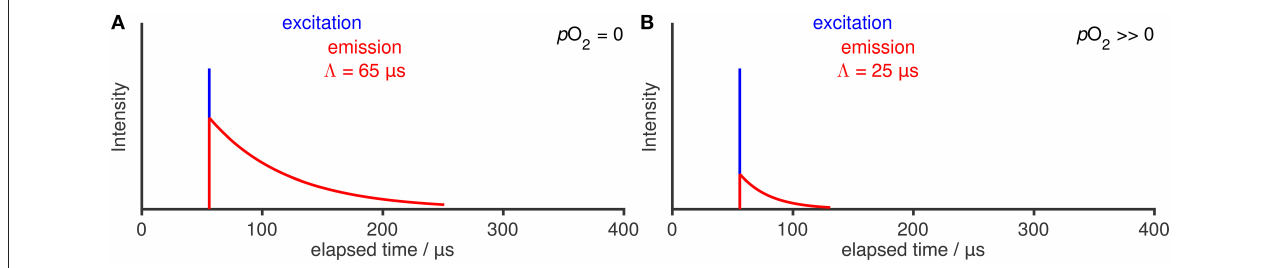
FIGURE 1 | Illustration of a luminescence decay (A) under absence of O 2 and (B) with quenching in presence of O 2 . Only a single, short impulse excitation of the luminophore (blue) and its associated luminescence decay (red) is